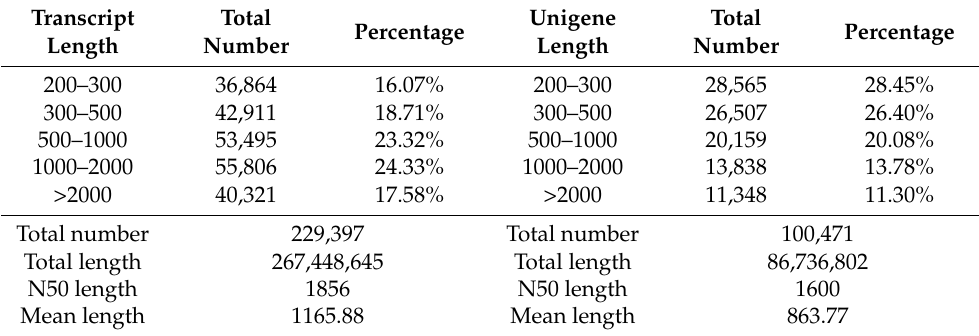
Table 1. Assembly summary of 24 ‘TY’ transcriptome samples.